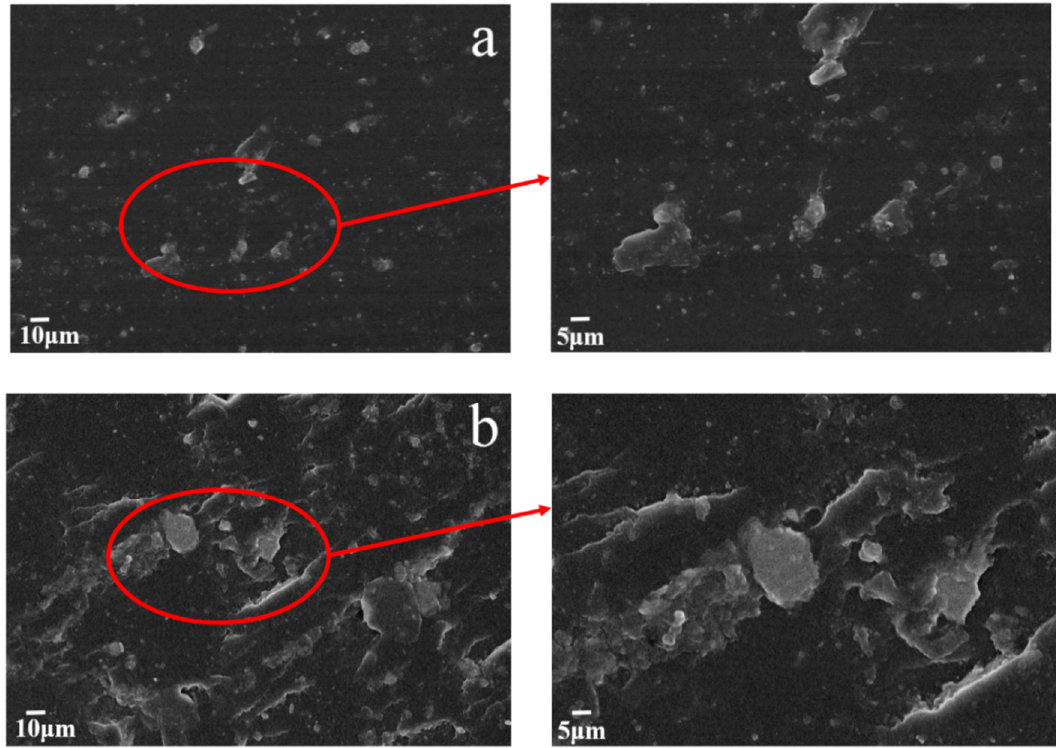
Figure 5. Micrographs of the dispersion state of MGO on the cross section of the MGO / WPU composite coating with different contents of MGO, ( a ) 1.5 wt.%, ( b ) 3.5 wt.%.